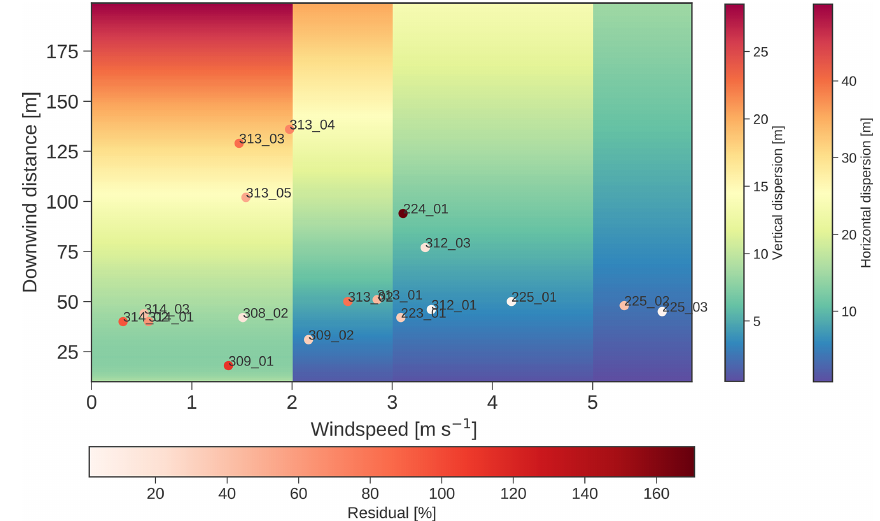
Figure 8. Theoretical horizontal and vertical spread of a plume with respect to wind speed and downwind distance. White to red dots refers to the individual error of each quantification flight, lighter being more accurate than darker dots.